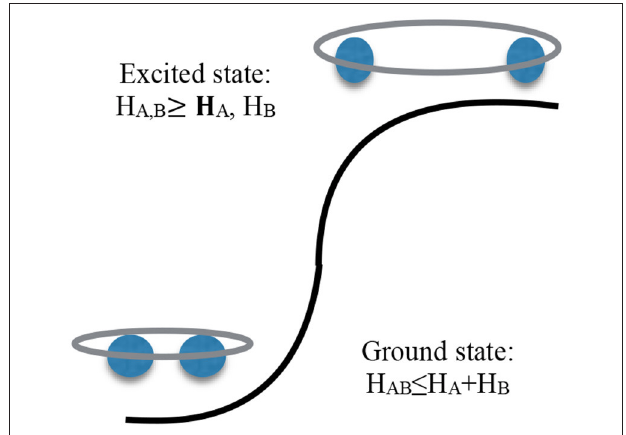
FIGURE 5 | A notional aspect of the transactions modeled by the sigmoidal function in Equation